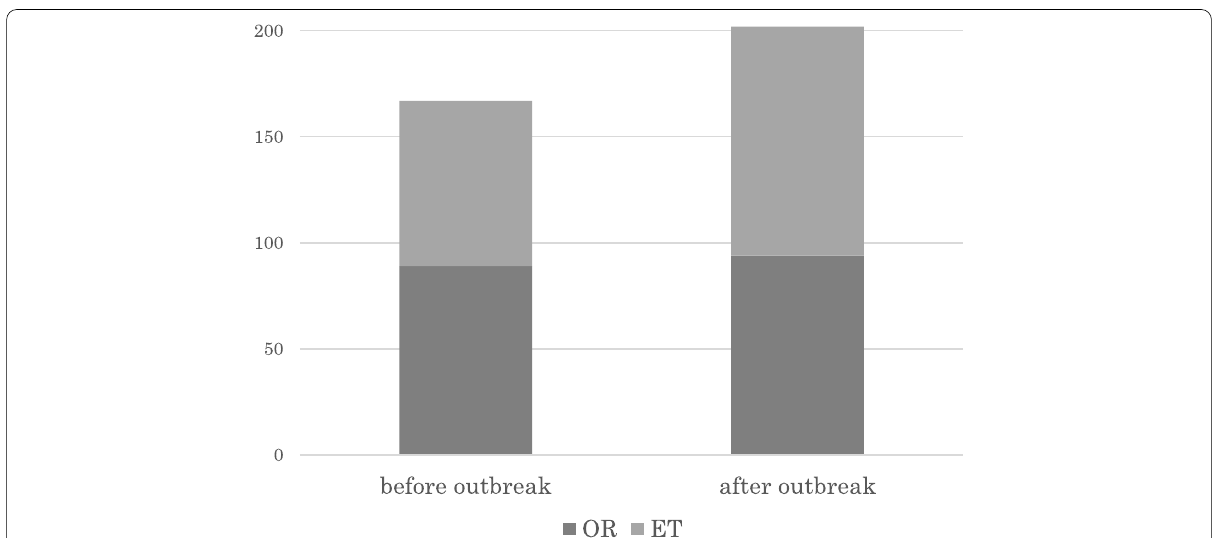
Fig. 1 A cChange of oocyte retrieval and embryo transfer cycles before and after the pandemic. A cChange of oocyte retrieval (OR) and embryo transfer (ET) cycles before and after the outbreak. Both the number of OR and ET increased, and the number of treatments in patients aged over 40 remarkably increased after the outbreak. Polymerase chain reaction testing was implemented for all patients. The rRate of self-injection was 84%